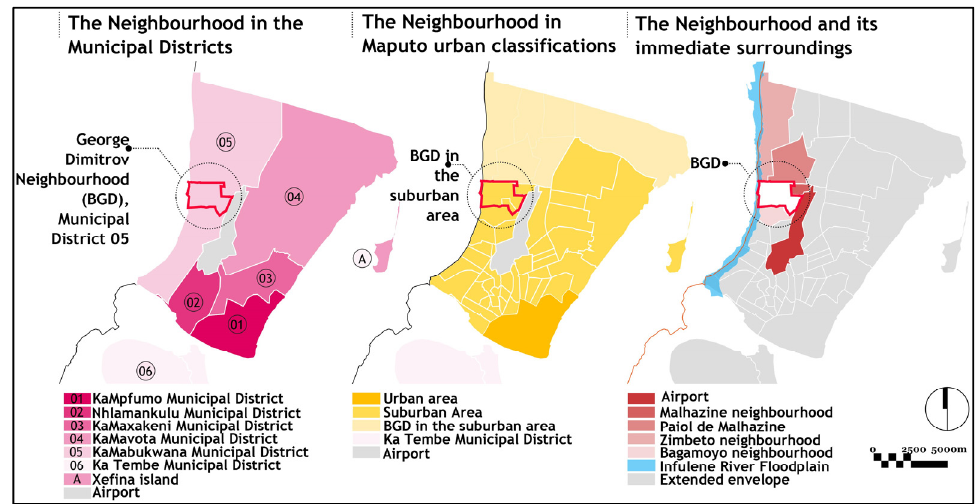
Figure 8. The George Dimitrov Neighbourhood in the context of Maputo.